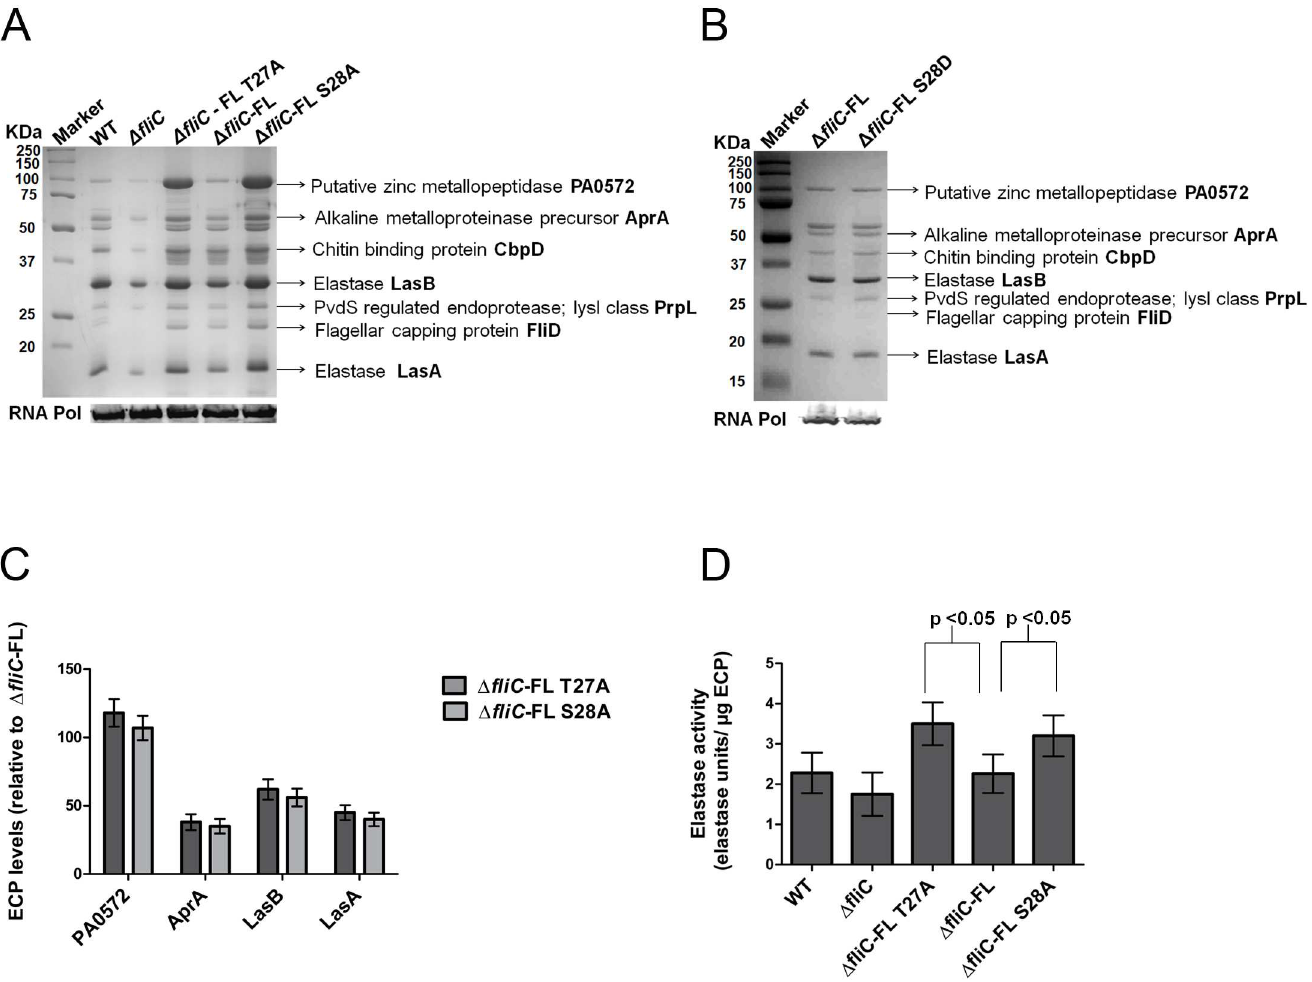
Fig 2. FliC phosphorylation affects type 2 secretomelevels. (A& B) Total extracellular protein (ECP) from PAO1 WT, Δ fliC , Δ fliC -FL T27A, Δ fliC -FL and Δ fliC -FL S28A strains loadedbased on protein secreted from equal no of cells as shown by RNA polymerase (RNA Pol) α -subunit blotting (bottom panel). (C) Quantification of proteasesfrom (A) by Image J 1.43 software (http://rsbweb.nih.gov/ij/) showingincrease in representative T2SS proteases of Δ fliC -FL T27A and Δ fliC -FL S28A. Error bars represent mean ± SD from six independent biologicalreplicates. All differences indicatedare significant with student’s t-test p-values < 0.05. (D) Elastolytic activity assay of elastase secreted by PAO1 WT, Δ fliC , Δ fliC -FL T27A, Δ fliC -FL and Δ fliC -FL S28A strains. Error bars represent mean ± SD computed from five biologicalreplicates with student’s t-test p-values < 0.05 for Δ fliC -FL T27A vs. Δ fliC –FL and Δ fliC -FL S28A vs. Δ fliC